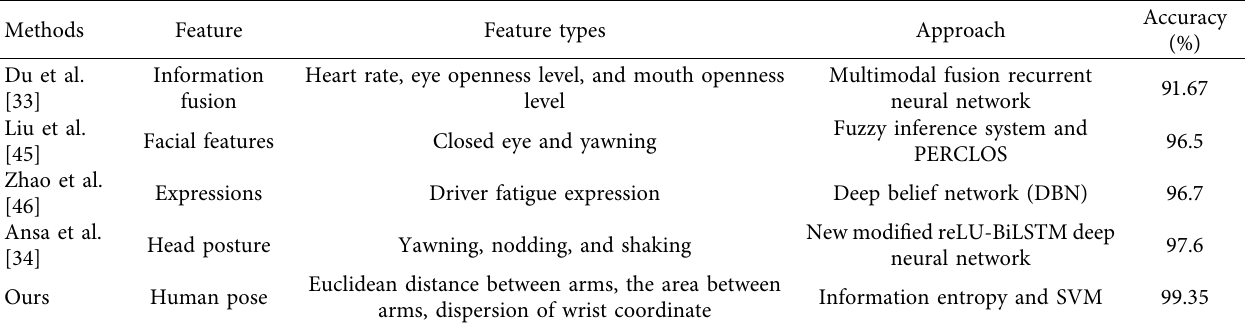
Table 6: Comparison of the proposed method with other